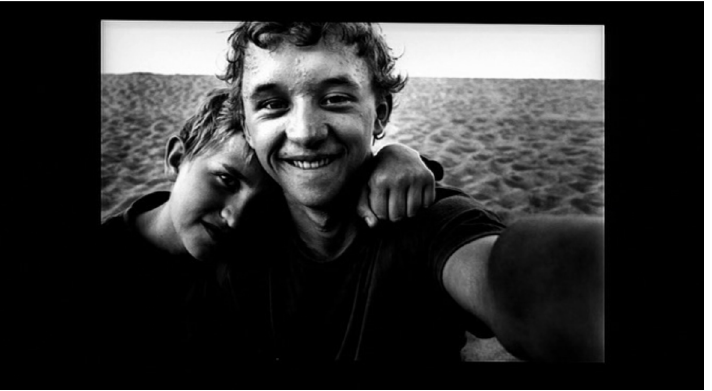
Figure 5. The Return (2003).